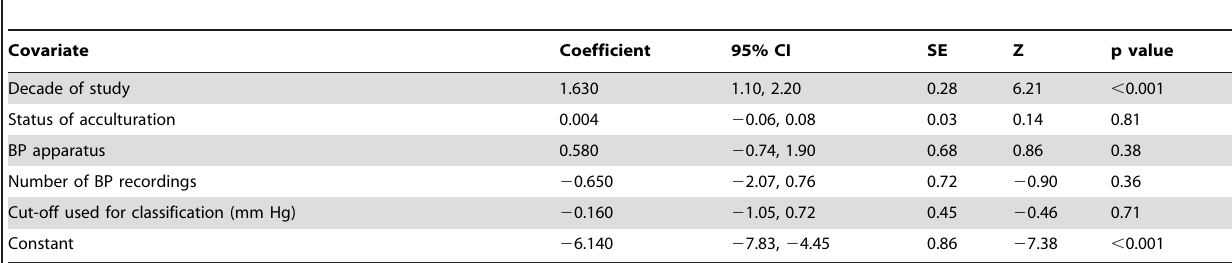
Table 3. Random effects meta-regression analysis – effect of covariates on the prevalence of hypertension.